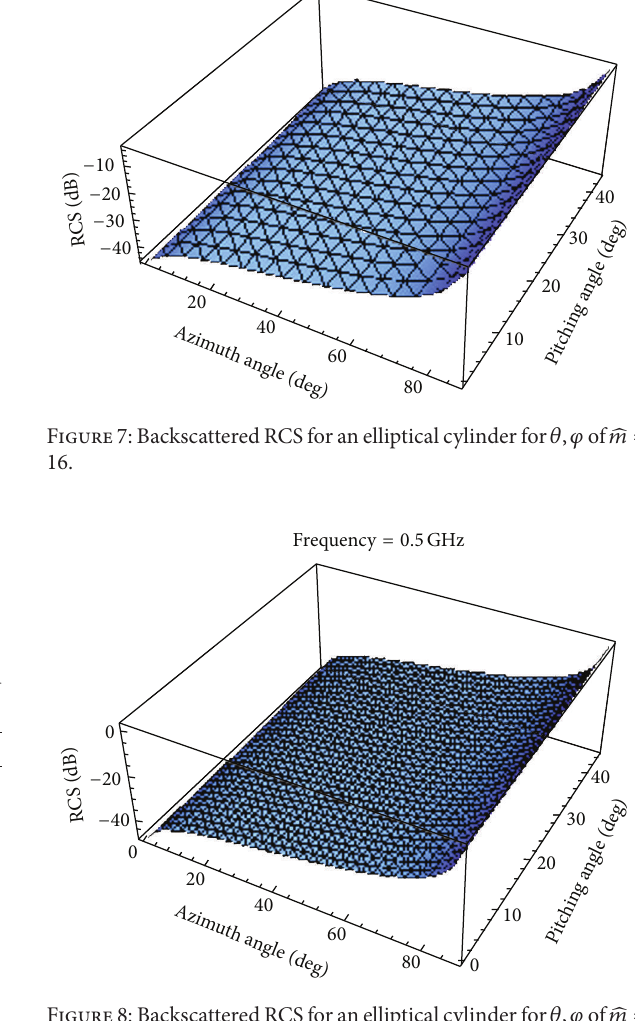
Figure 8: Backscattered RCS for an elliptical cylinder for 𝜃, 𝜑 of ̂𝑚 = 32.